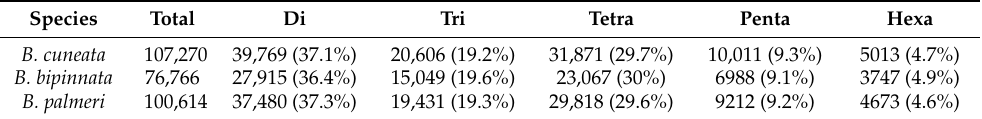
Table 4. Frequencies of dinucleotide to hexanucleotide simple sequence repeats identified in three Bursera